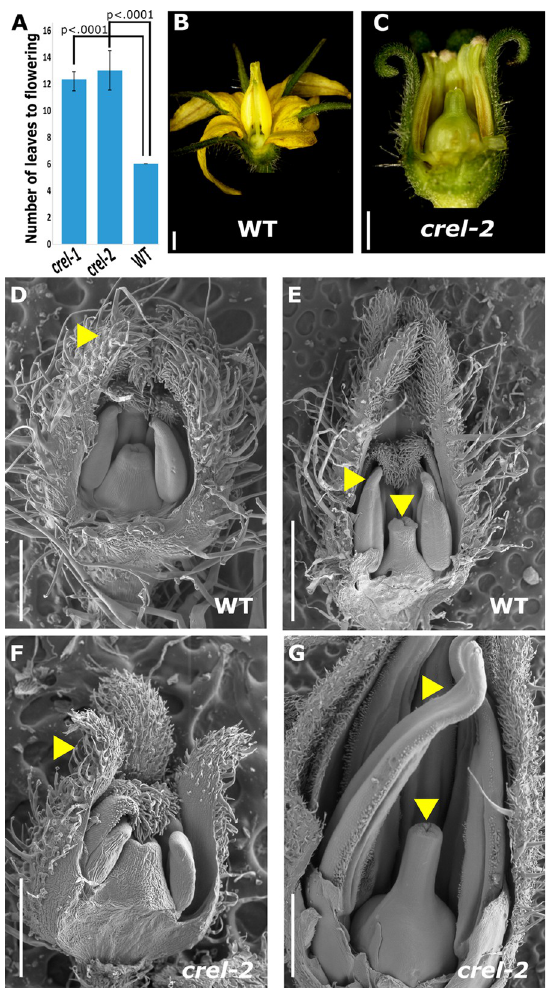
Fig 6. CREL promotes flowering, floral organ growth, and differentiation. (A) Flowering time, measured by number of leaves produced before flowering, of the indicated genotypes. Error bars represent the SE; p -values indicate differences from WT, as determined by Dunnett‘s test. n = 12 (wt, crel-1 ) and 4 ( crel-2 ). (B, C) Stereoscope images of mature flowers. Scale bars: 1mm. (D-G) Scanning electron microscope (SEM) micrographs of the indicated genotypes at 2 early developmental stages. D, F—0.5 mm long stage 6 flowers; E, G—1 mm long stage 11 flowers (according to [57]. Yellow arrowheads point to normal (WT, D) and distorted ( crel-2 , F) young petals, and to normal (WT, E) and distorted ( crel-2 , F) stamens and stigma. Scale bars: 1mm (E, G); 0.5mm (D, F).